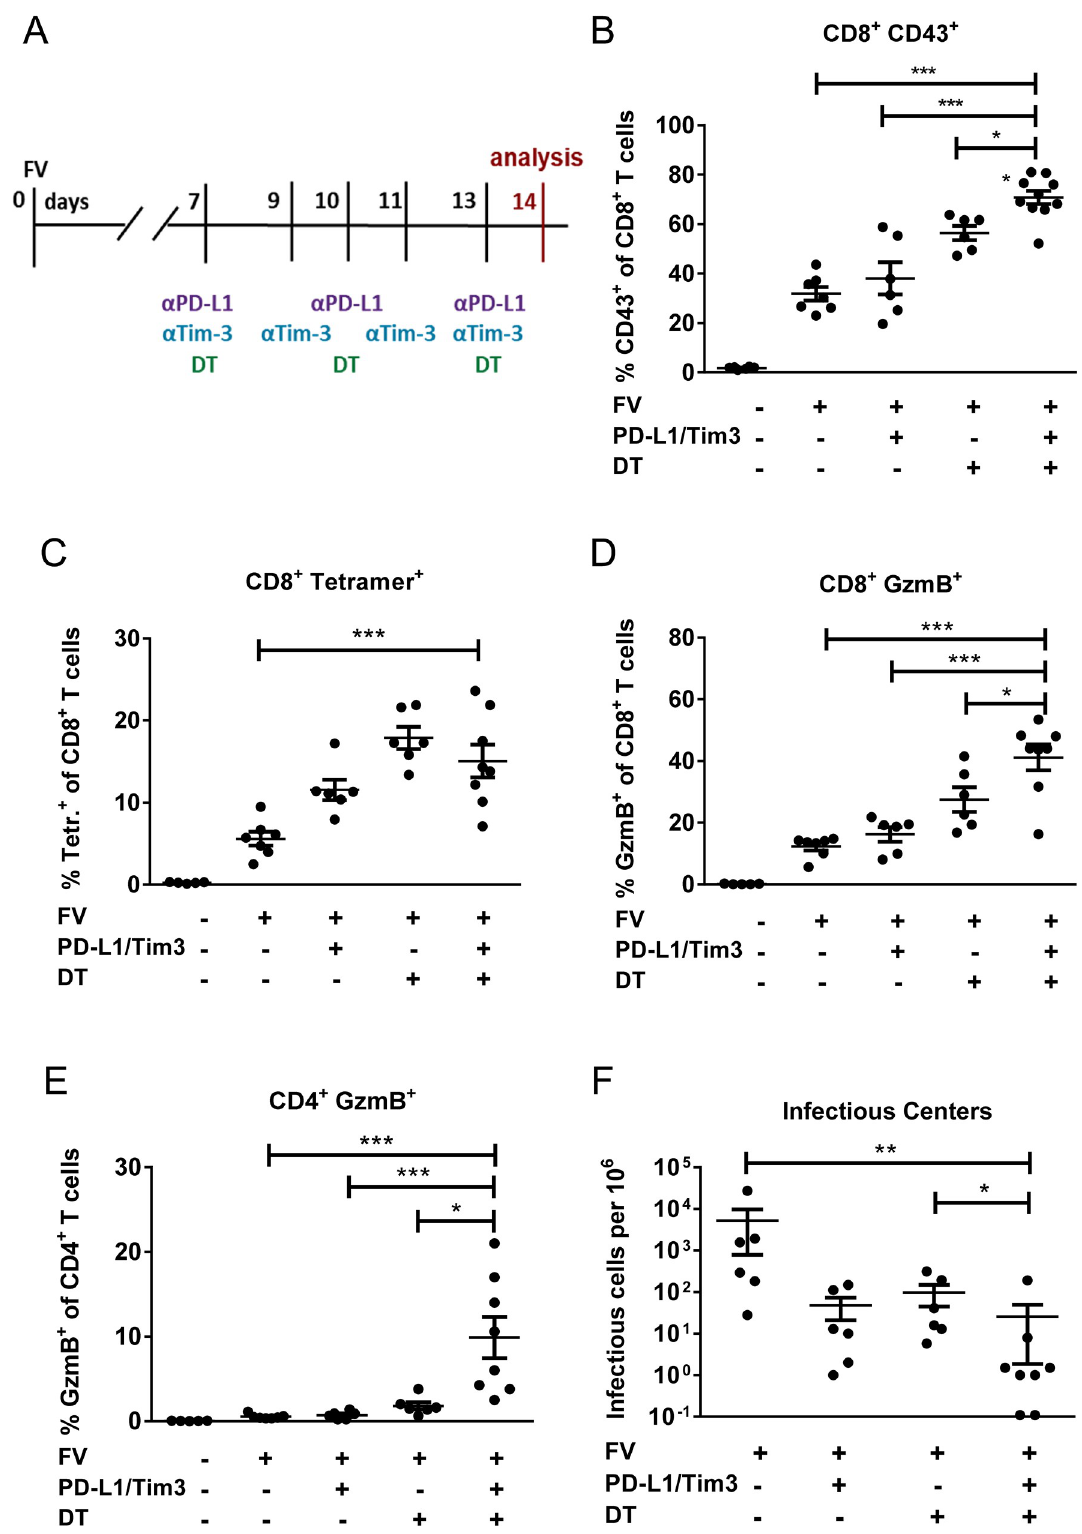
Fig 1. Reduced levels of FV and enhanced number of CD8+ and CD4+ T cells producing GzmB after Treg depletion and/or inhibitory pathway blockage in acutely infected mice. DEREG mice were infected with FV and treated with DT and/or